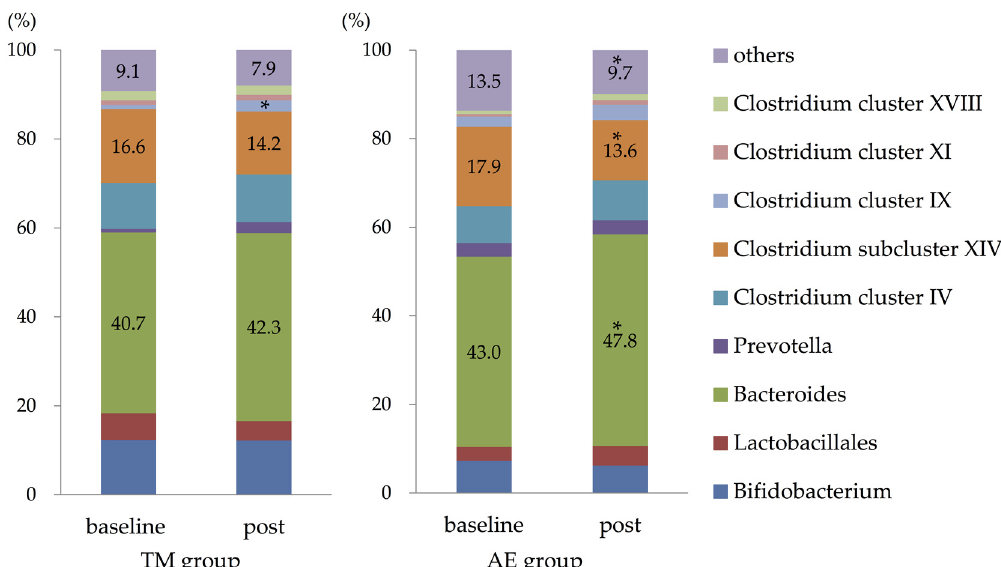
Figure 3. Changes in the composition of the intestinal microbiota following the intervention. The relative abundance of intestinal Bacteroides was significantly increased, and that of the Clostridium subcluster XIVa was decreased only in the AE group (by the Wilcoxon Signed-rank test). The relative abundance of Clostridium cluster IX was significantly increased only in the TM group. *: p < 0.05 compared with baseline. Abbreviations: TM, trunk muscle training; AE, aerobic exercise training.